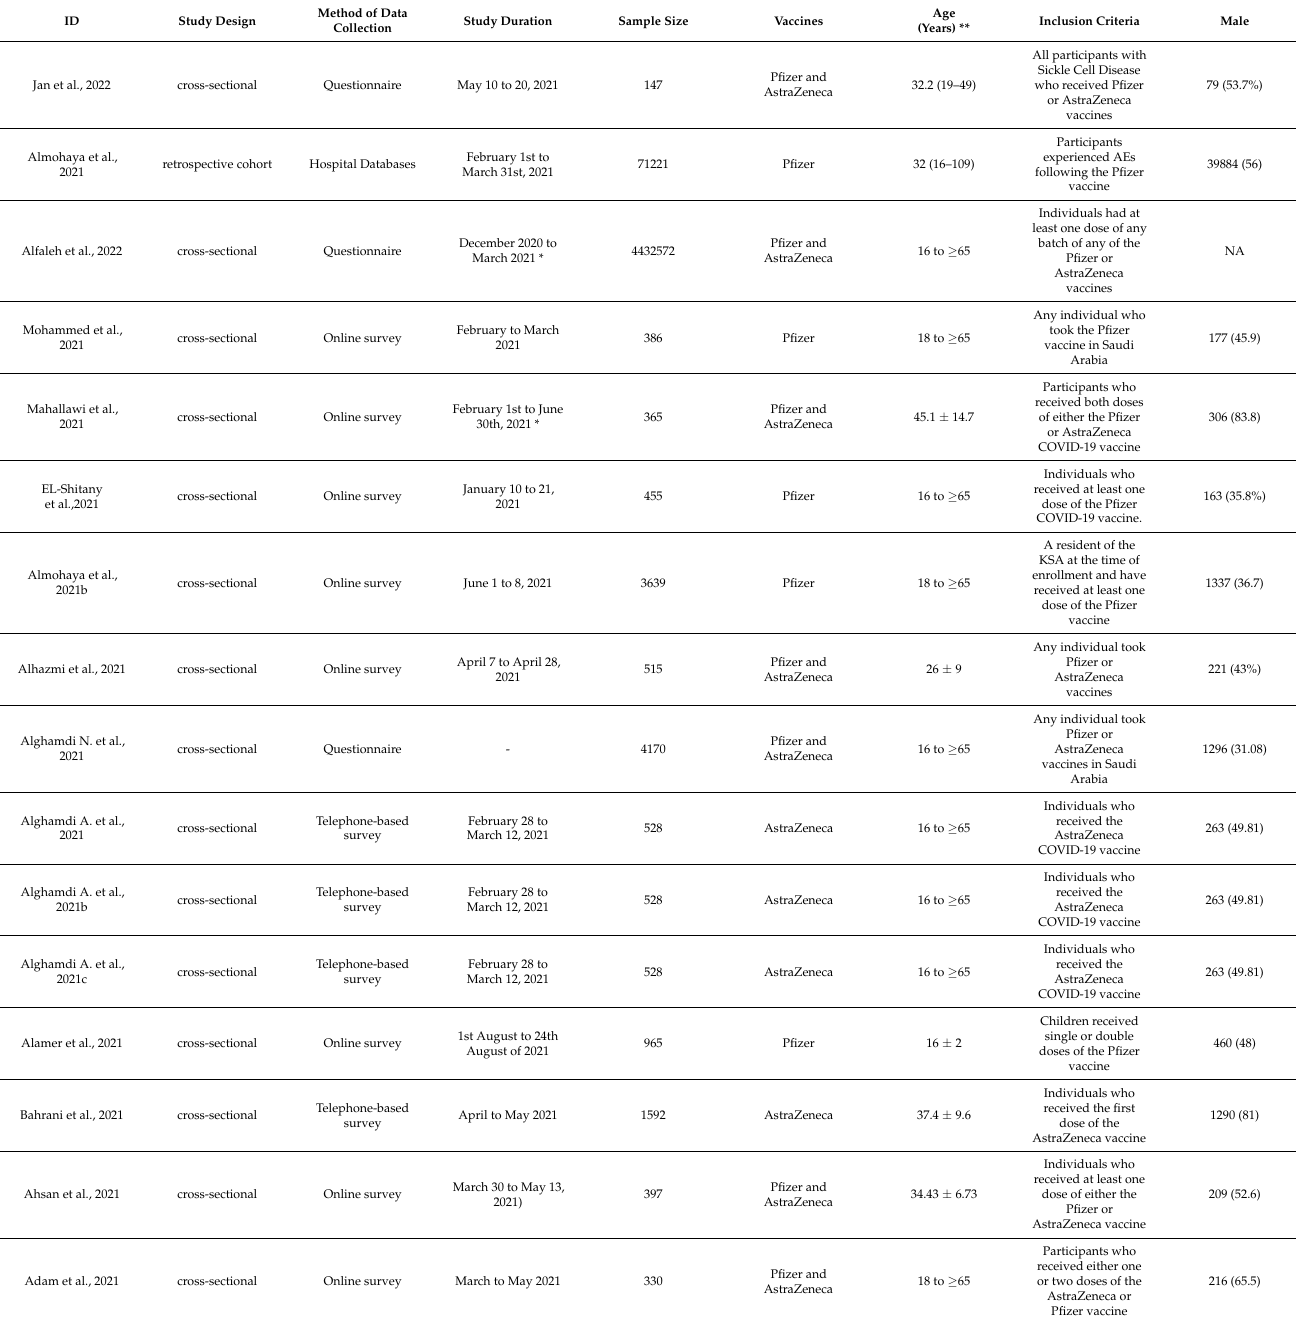
Table 1. Summary of Included